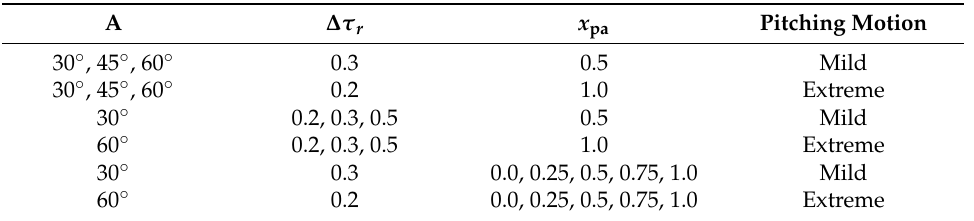
Table 2. Extreme and mild cases considered.